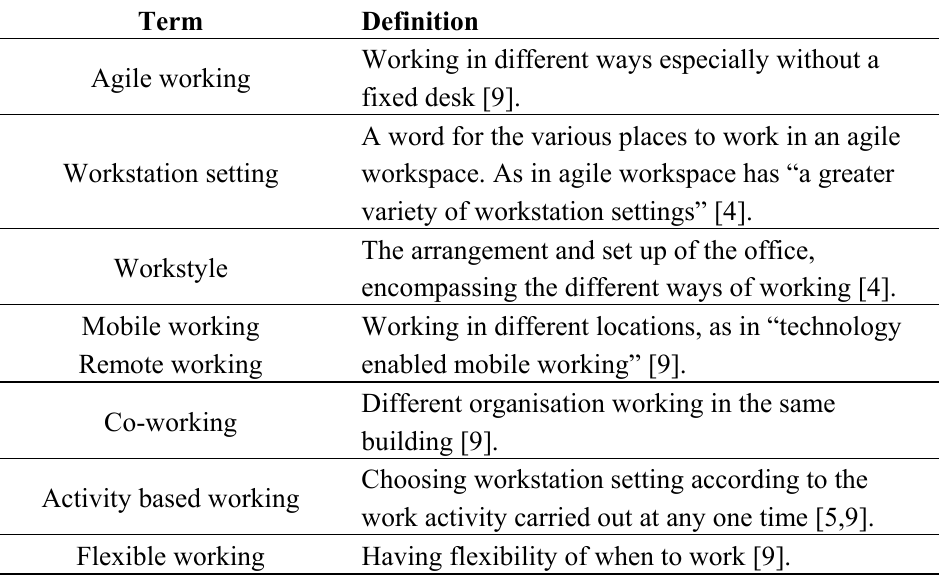
Table 1. Overview of terminology used in commercial